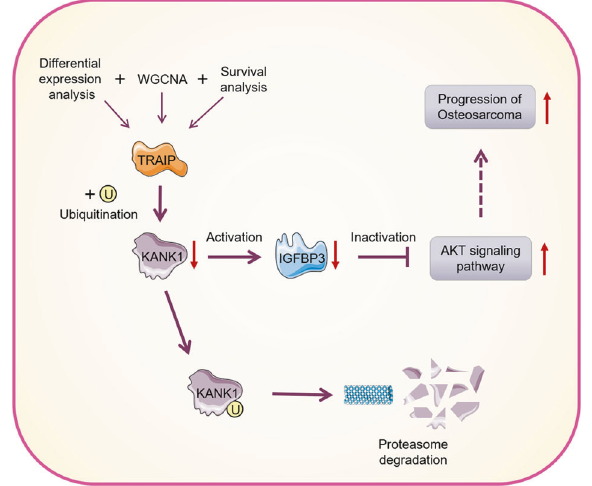
Fig. 8 A schematic representation of TRAIP as a key prognostic DEG between CTCs and metastatic lesions in osteosarcoma. TRAIP targets KANK1 for degradation, activating the IGFBP3/AKT signaling pathway and promoting osteosarcoma cell proliferation and